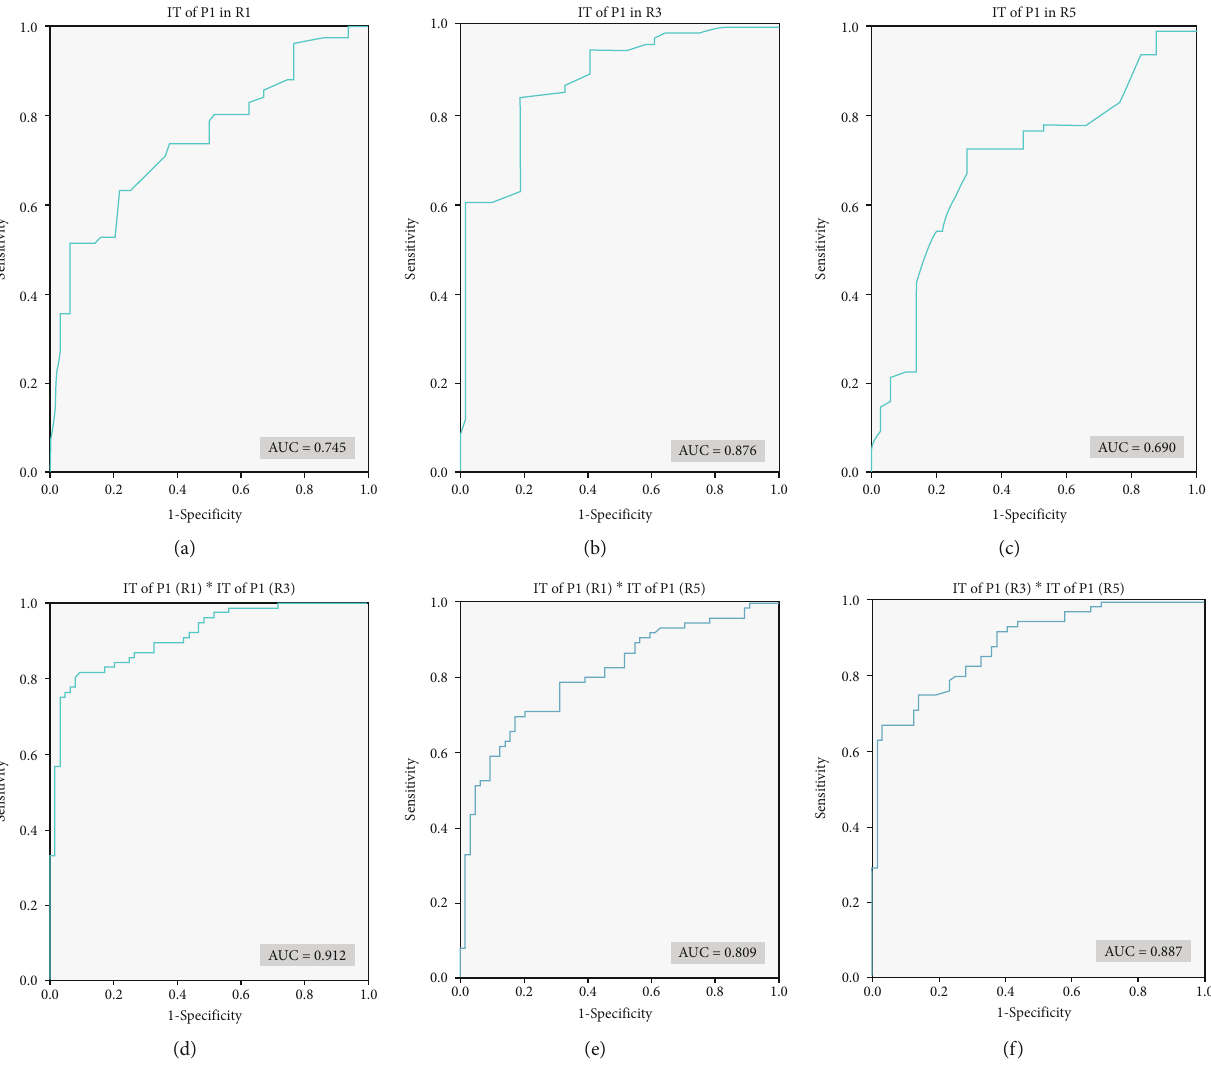
Figure 4: (a) – (c) shows ROC curves of the single parameter of mf-ERG for diagnosing diabetic retinopathy. (d) – (f) shows ROC curves of multiparameters of mf-ERG for diagnosing diabetic retinopathy. IT: implicit time; R1: ring 1; R3: ring 3; R5: ring